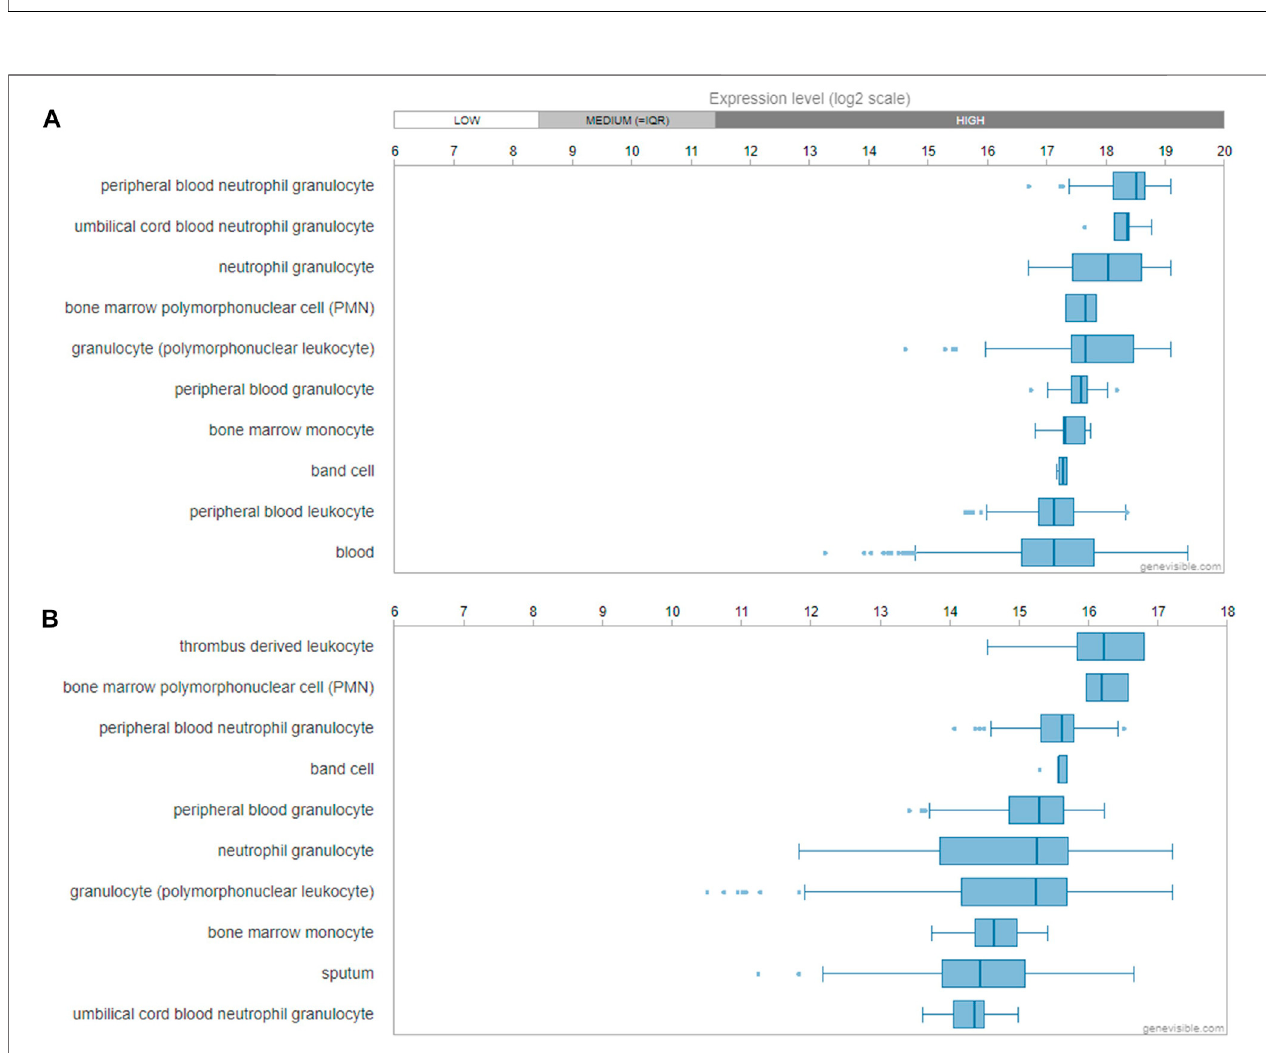
FIGURE 10 | Gene expression pro fi ling of FPR1 and FPR2. mRNA expression pro fi ling of FPR1 (A) and FPR2 (B) gene in human tissues and cells predicted by Genevisible ® bioinformatics tool (http://genevisible.com), with the ten most highly ranking mRNA express levels, respectively.